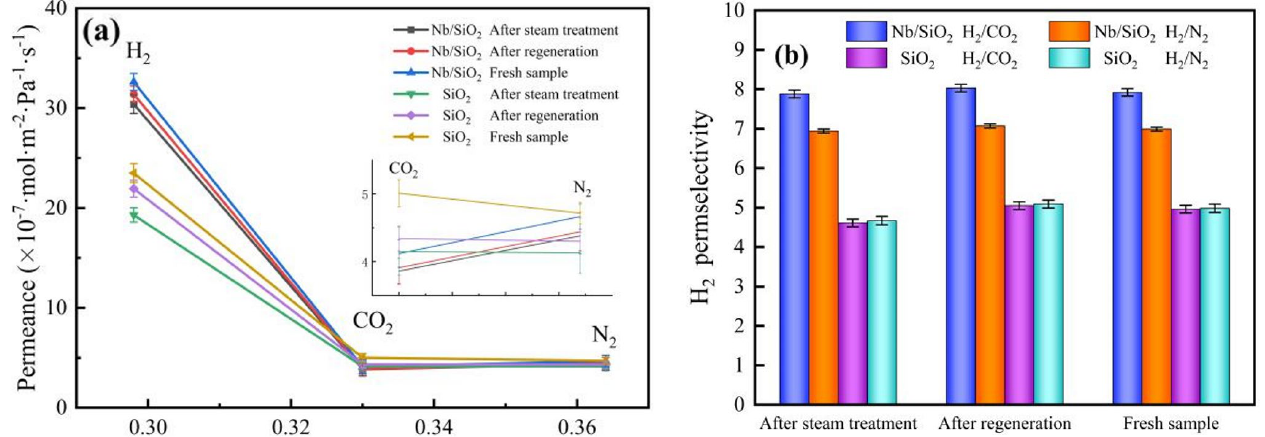
Figure 19. ( a ) Gas permeance and H 2 permselectivities and ( b ) H 2 permselectivities of Nb/SiO 2 membranes with n Nb = 0 and 0.08 at a pressure difference of 0.1 MPa before and after steam treatment and regeneration.